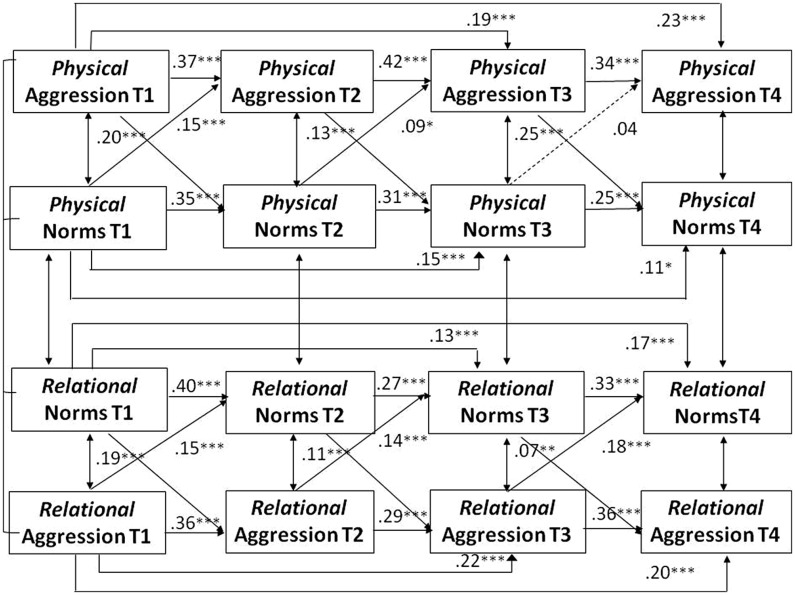
Boys’ paths of physical and relational aggression and normative approval over four data waves.
N = 892. Standardized coefficients are shown. All model variables controlled for year cohort, ethnic background, and school type. Coefficients for the cross-sectional associations included in the model are shown in Table 3. Broken lines indicate non-significant paths.